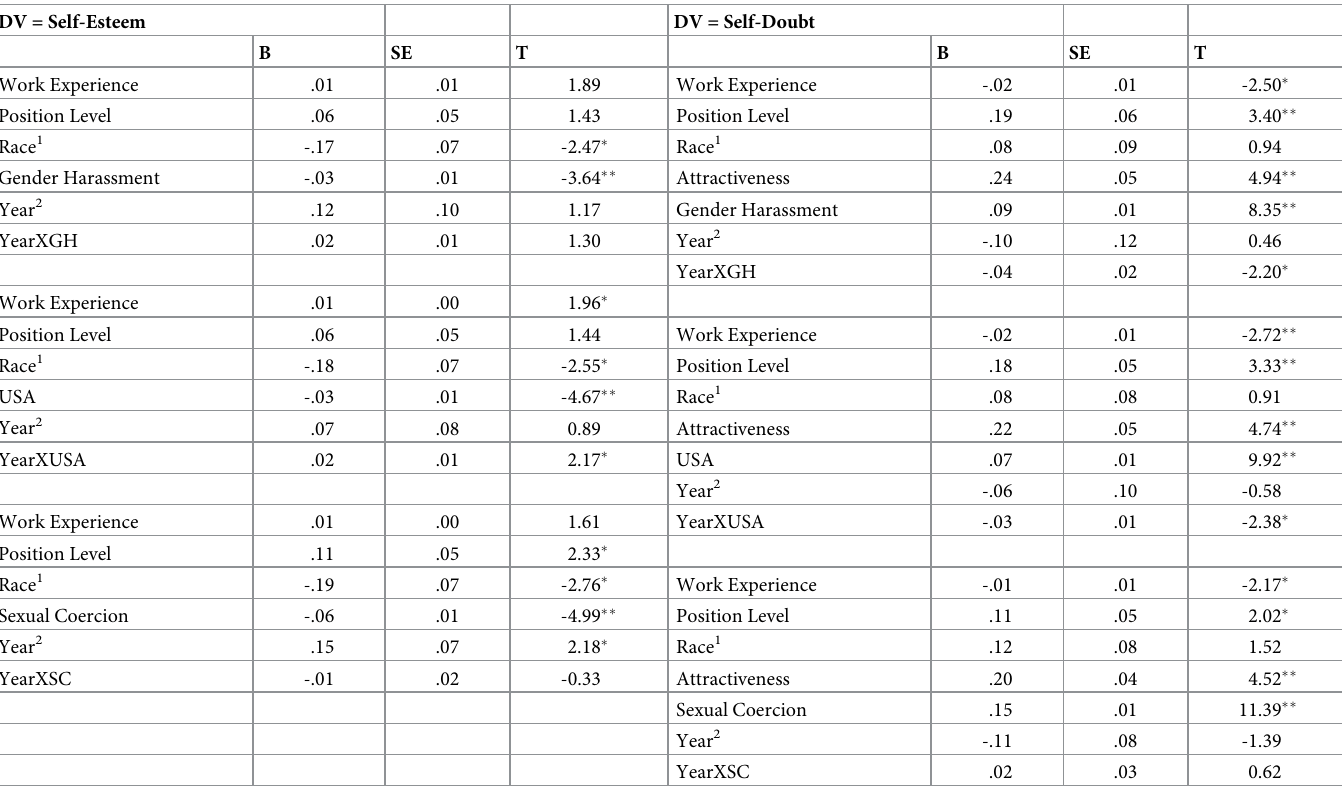
Table 4. General Linear Model regressing self-esteem and self-doubt on the relationship between year and sexual harassment. Unwanted sexual attention has a less negative relationship with self-esteem in 2018. Gender harassment and unwanted sexual attention were less positively related to self-doubt in 2018. 1 Race is coded